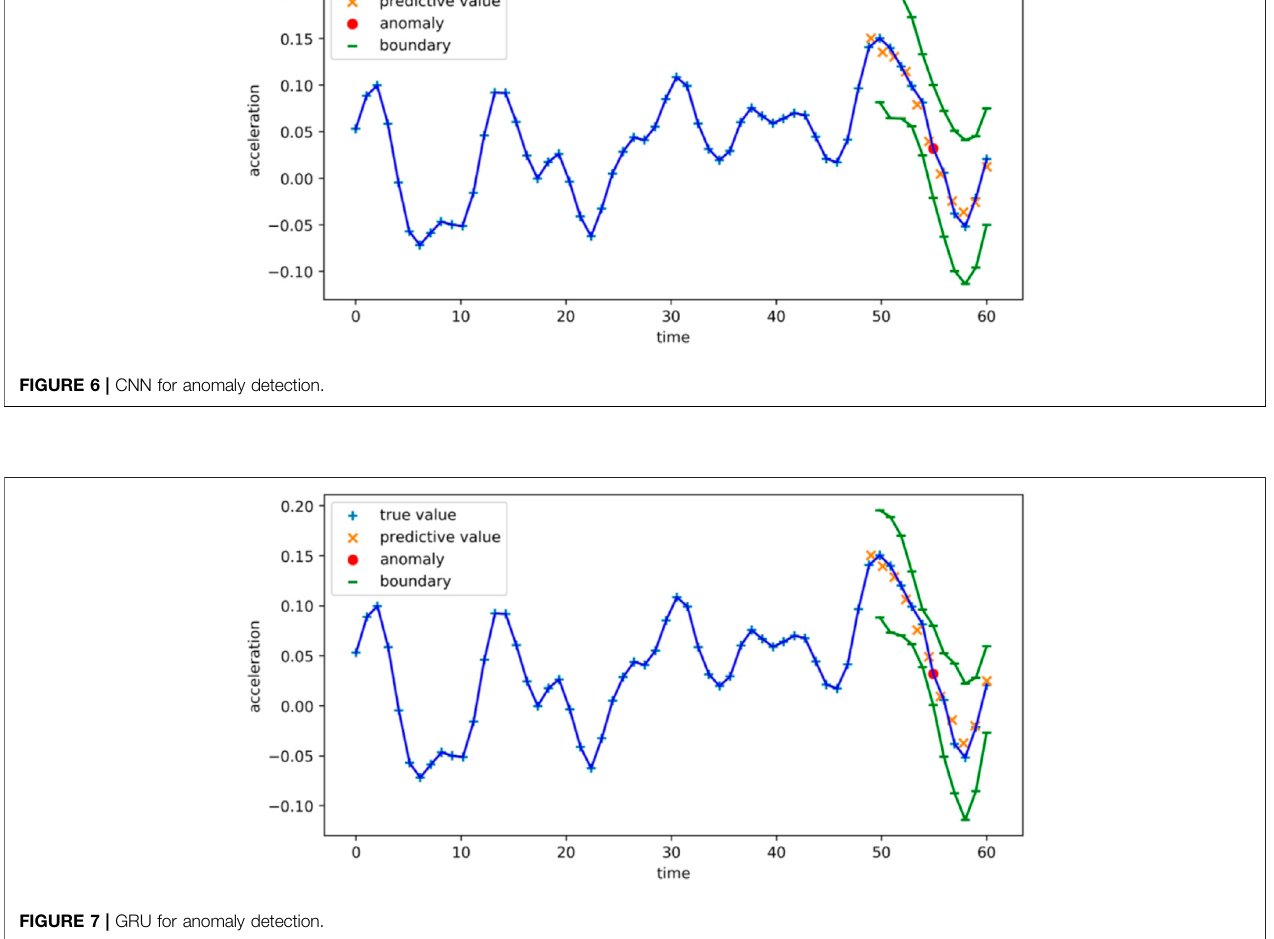
FIGURE 7 | GRU for anomaly detection.